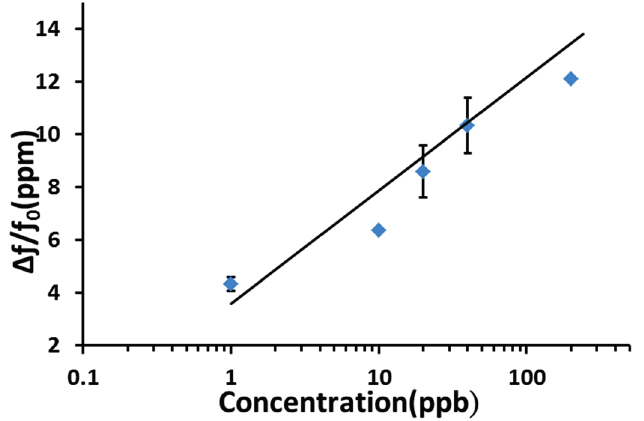
Figure 6. Frequency shifts of the sensor in response to various NO concentrations ranging from 1 ppb to 200 ppb using dry nitrogen as carrier gas at room